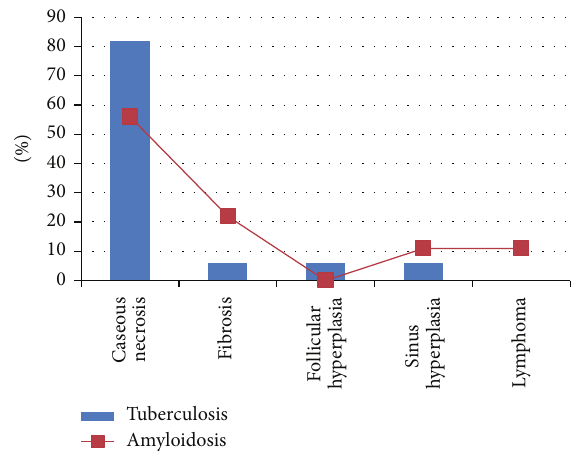
Figure 1: Description of tuberculosis and amyloidosis positive patients by